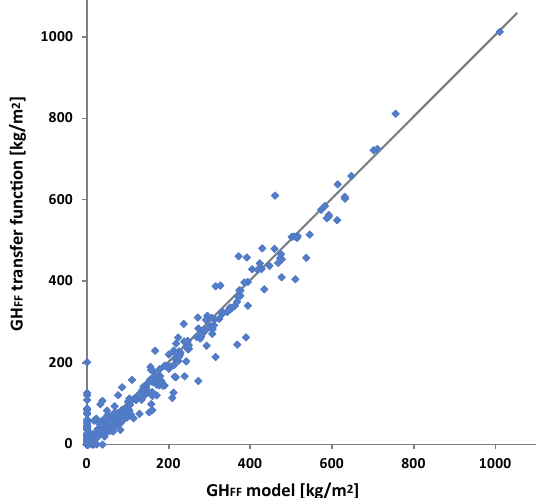
Fig. 8. Cross-plot of the depth integrated gas hydrate masses (GH FF ) estimated by the extended transfer function calculated fol- lowing Eq. (8) and by the numerical model. The solid line shows the 1 : 1